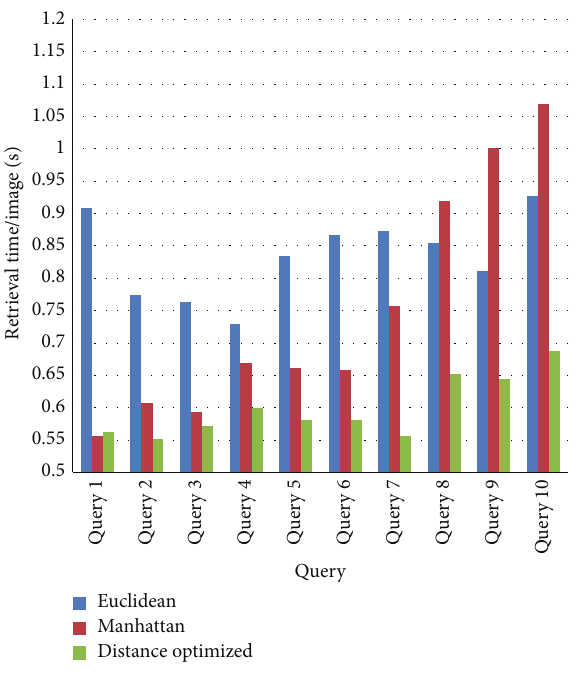
Figure 11: Image retrieval rate comparison.